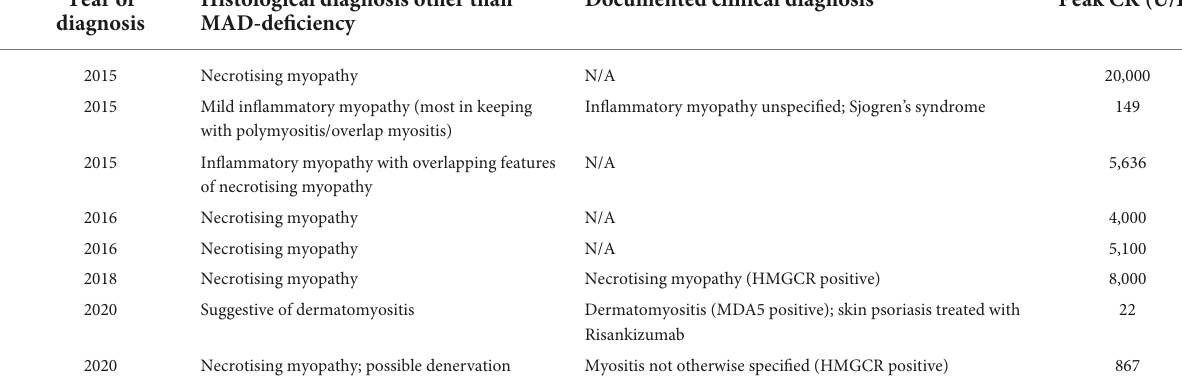
TABLE 1 Characteristics of myoadenylate deaminase (MAD)-deficient cases with myositis. Year of diagnosis